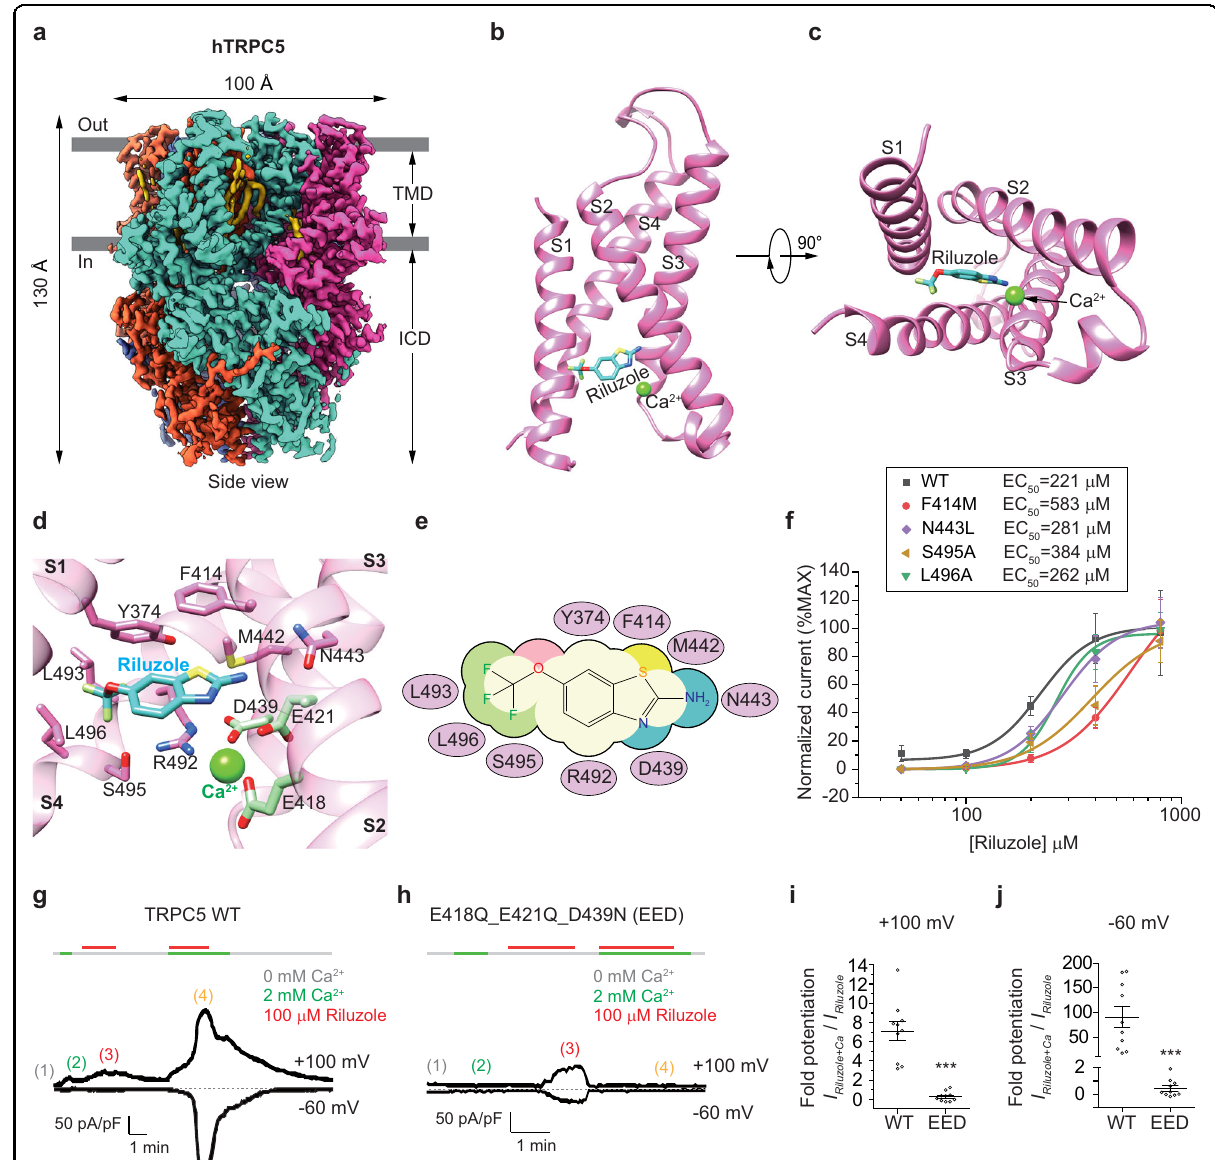
Fig. 1 Structure of the hTRPC5 channel in complex with riluzole. a The cryo-EM density map of riluzole-bound hTRPC5 shown in side view. Four subunits are colored in hot pink, cyan, orange and blue, respectively. Lipids are colored in yellow. The cell membrane is indicated by gray lines. TMD, transmembrane domain; ICD, intracellular cytosolic domain. b , c Overview of the riluzole-binding site in hTRPC5. Riluzole is shown as sticks and colored in light sea green. Ca 2 + ion is shown as a green sphere. Side view ( b ) and bottom view ( c ) are shown. d Close-up view of the riluzole-binding site and Ca 2 + - binding site. The main chains of hTRPC5 are shown as cartoons and colored in transparent hot pink. Side chains of interacting residues are shown as sticks. Residues colored in hot pink and D439 interact with riluzole. And residues colored in light green interact with Ca 2 + . e Cartoon representation of the interaction between riluzole and hTRPC5. Interacting residues are labeled in the purple ovals. f The activation effects of riluzole on various hTRPC5 mutants, measured by electrophysiological recordings under 0mM extracellular Ca 2 + at − 100mV. Representative traces are shown in Supplementary Fig. S3. Recordings from at least 10 cells were analyzed for each mutant. Data were fi tted by dose-response curves and were normalized to ‘ max currents ’ (the maximal response produced by the drug). Data are shown as means±SEM. g , h Ca 2 + -dependent potentiation of riluzole-activated TRPC5 currents of wild- type (WT) ( g ) and TRPC5_E418Q_E421Q_D439N mutant (EED) ( h ). TRPC5 currents were elicited by 2s voltage ramps from − 60mV to + 100mV, applied at 0.33Hz from a holding potential of − 60mV. The currents at + 100mV (the steady currents of 500ms step of + 100mV at end of ramp, top trace) and − 60mV (the steady currents of 100ms step of − 60mV before ramp, bottom trace) are plotted. Stimuli of 2mM extracellular Ca 2 + (marked as green lines) and 100 μ M riluzole (marked as red lines) were individually or synergistically applied to cells. Basal condition of 0mM extracellular Ca 2 + is marked as gray lines. Representative ramp traces at basal state (0mM Ca 2 + , marked with 1 and colored in gray), 2mM Ca 2 + (2, in green), 100 μ M riluzole in 0mM Ca 2 + (3, in red), and 100 μ M riluzole in 2mM Ca 2 + (4, in yellow) are shown in Supplementary Fig. S4 for comparison. i , j Statistical summaries of the fold potentiation of riluzole-activated current at + 100mV ( i ) or − 60mV ( j ) in 2mM Ca 2 + external relative to 0mM Ca 2 + external. n = 10 cells for each column. Data are